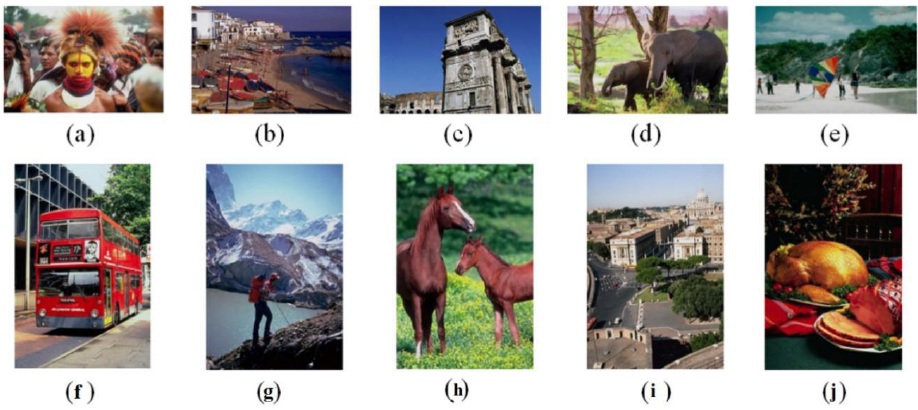
Figure 7. Example of the test images.